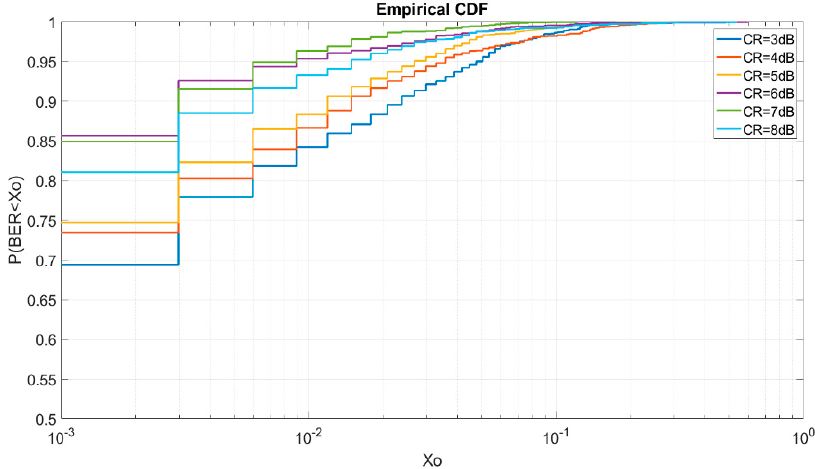
Figure 8. 6 W SC-FDE CR sweep CDF.